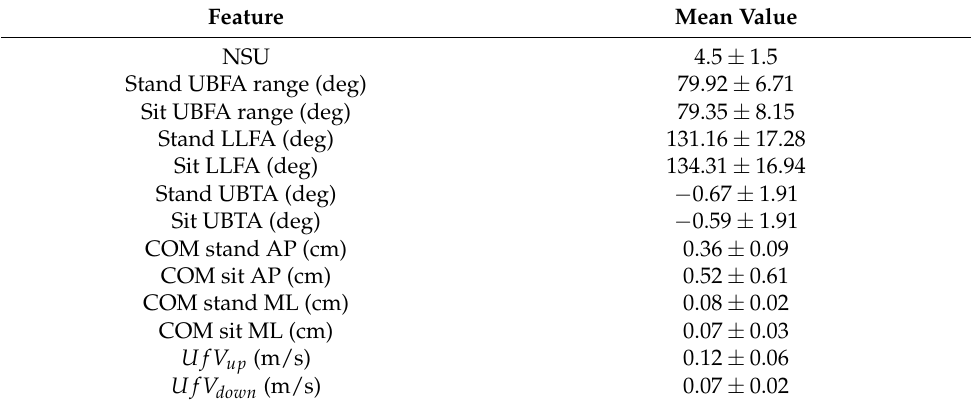
Table 1. Mean feature values. NSU, number of sit-up occurrences; UBFA, upper-body flexion angle; LLFA, lower-limb flexion angle; COM, center of mass; AP, anteroposterior; ML,